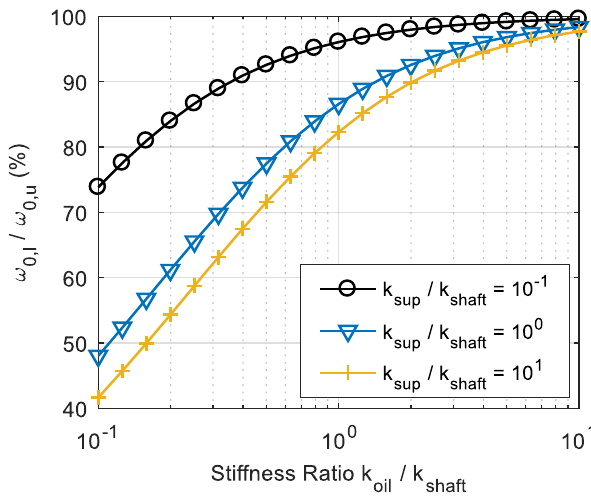
Figure 8. Shift of the resonance speed.